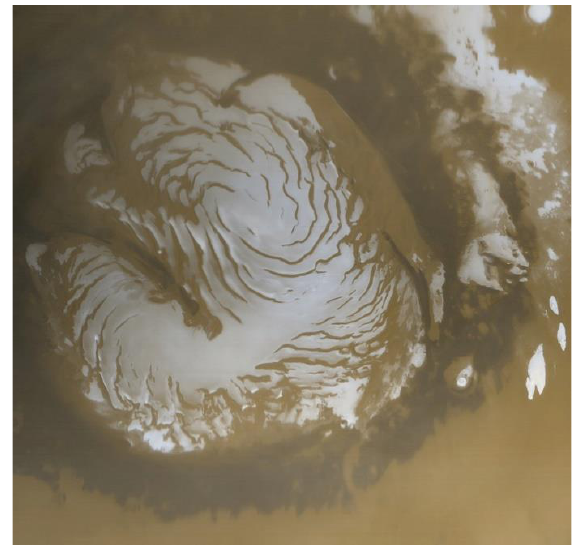
Figure 10. The Mars Global Surveyor acquired this image of the Martian north polar ice cap in early northern summer.